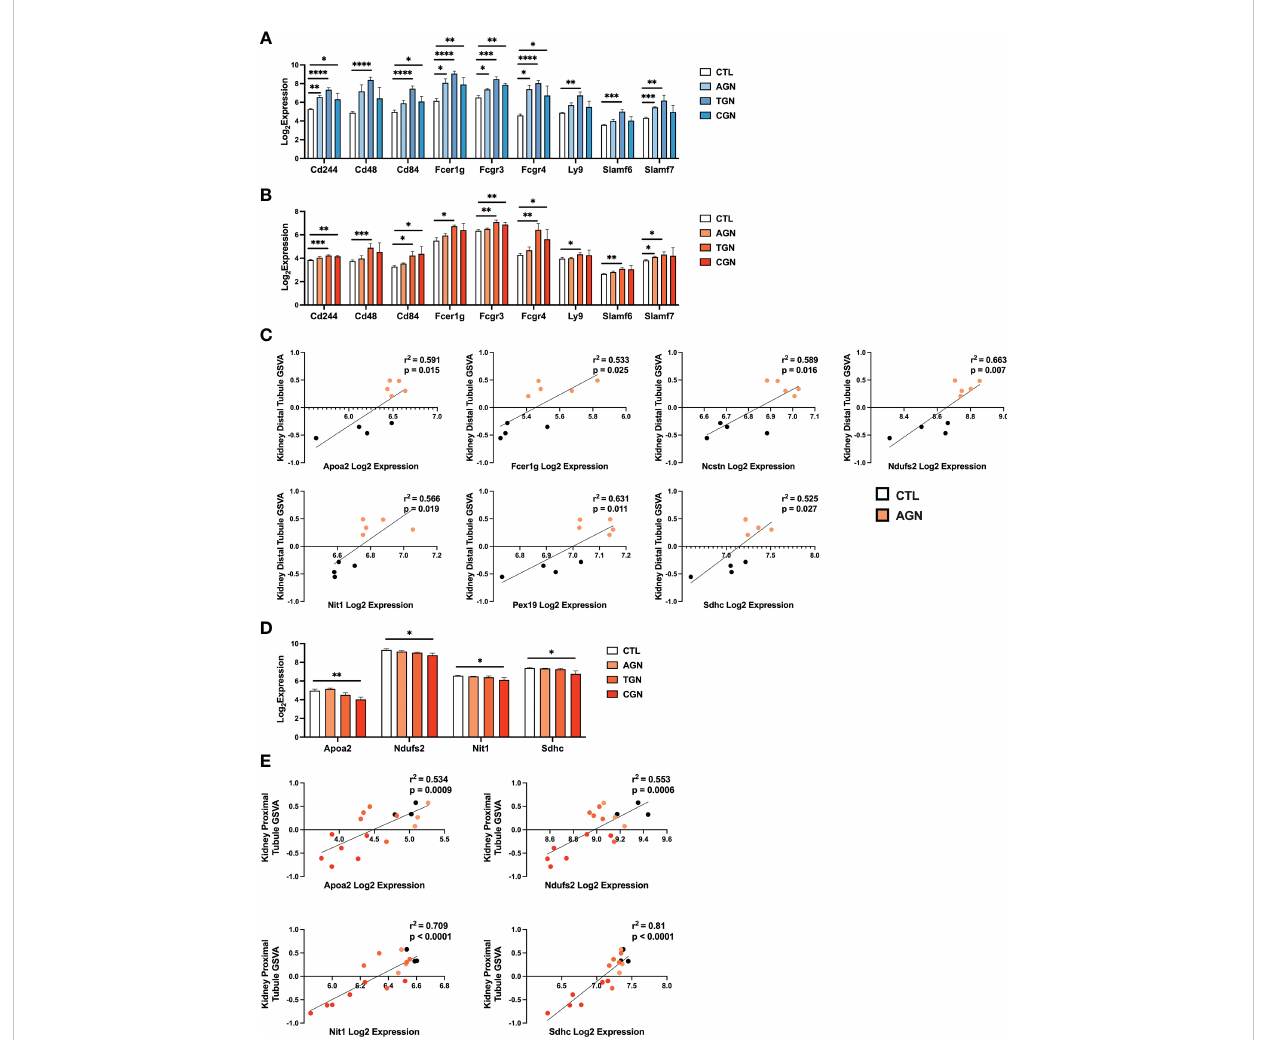
FIGURE 5 Expression of chronic risk locus genes is associated with disease severity and kidney tubule resistance in NZM2328 and R27 AGN mice. (A, B) Log 2 expression values of immune receptor genes in the Cgnz1 risk locus from glomeruli (A) and TI (B) of NZM2328 CTL, AGN, TGN, and CGN mice. (C) Linear regression between log 2 expression of Cgnz1 locus genes and GSVA scores of kidney tubule cells from the TI of R27 mice. All statistically signi fi cant correlations are shown. (D) Linear regression between log 2 expression of Cgnz1 locus genes from C and GSVA scores of kidney tubule cells from the TI of NZM2328 mice. All statistically signi fi cant correlations are shown. (E) Log 2 expression values Cgnz1 locus genes from C in the TI of NZM2328 CTL, AGN, TGN, and CGN mice. *p<0.05, **p<0.01, ***p<0.001,